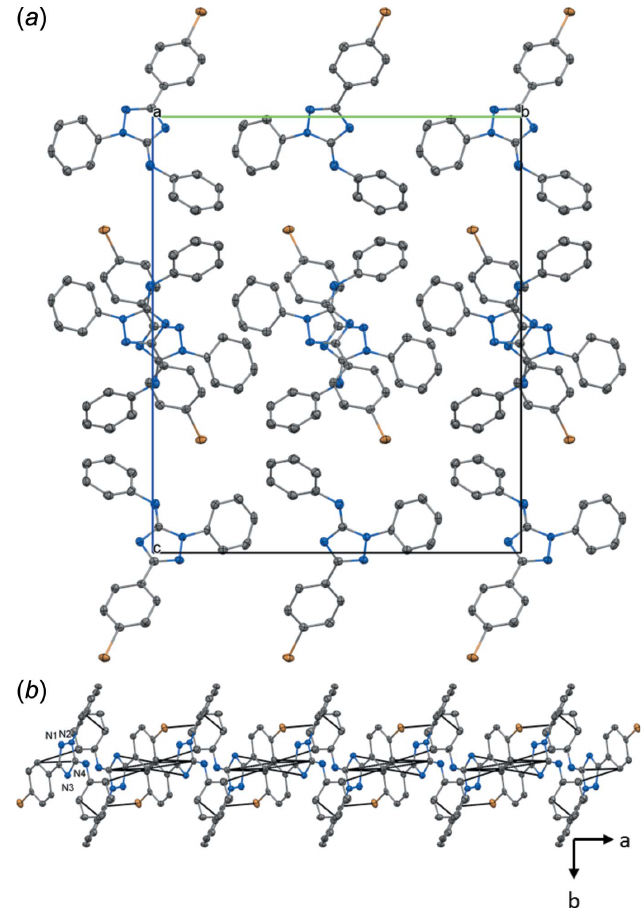
Figure 3 ( a ) Unit cell of 3 viewed parallel to the (100) plane. ( b ) Stacks of dimers formed along the a -axis direction. The nitrogen atoms of one molecule are